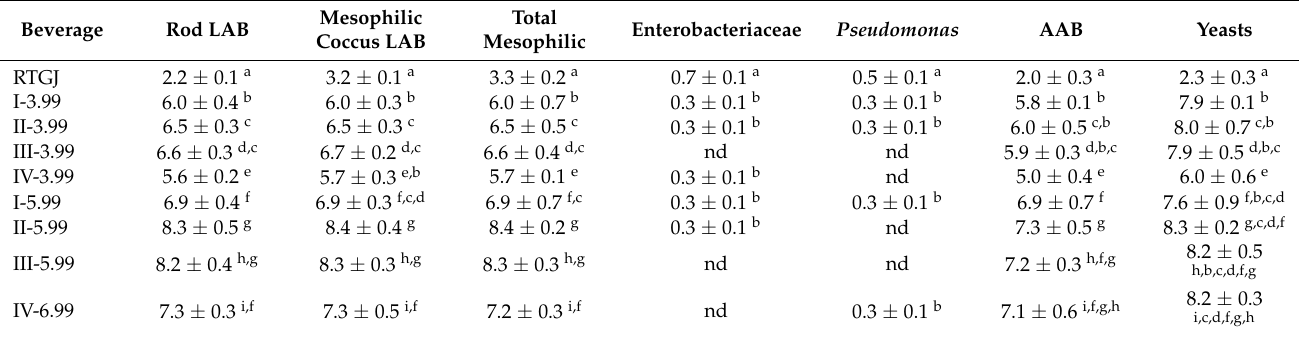
Table 1. Microbial Counts (Log CFU/mL) in the Red Table Grape Juice (RTGJ) and Fermented Beverages Obtained from the Four Subcultures in Fed-batch Fermentations A (I − 3.99, II − 3.99, III − 3.99 and IV − 3.99) and B (I − 5.99, II − 5.99, III − 5.99 and IV − 5.99). Each Result Is Shown as Mean ± Standard Deviation of Duplicate Samples and Three Analytical Replications